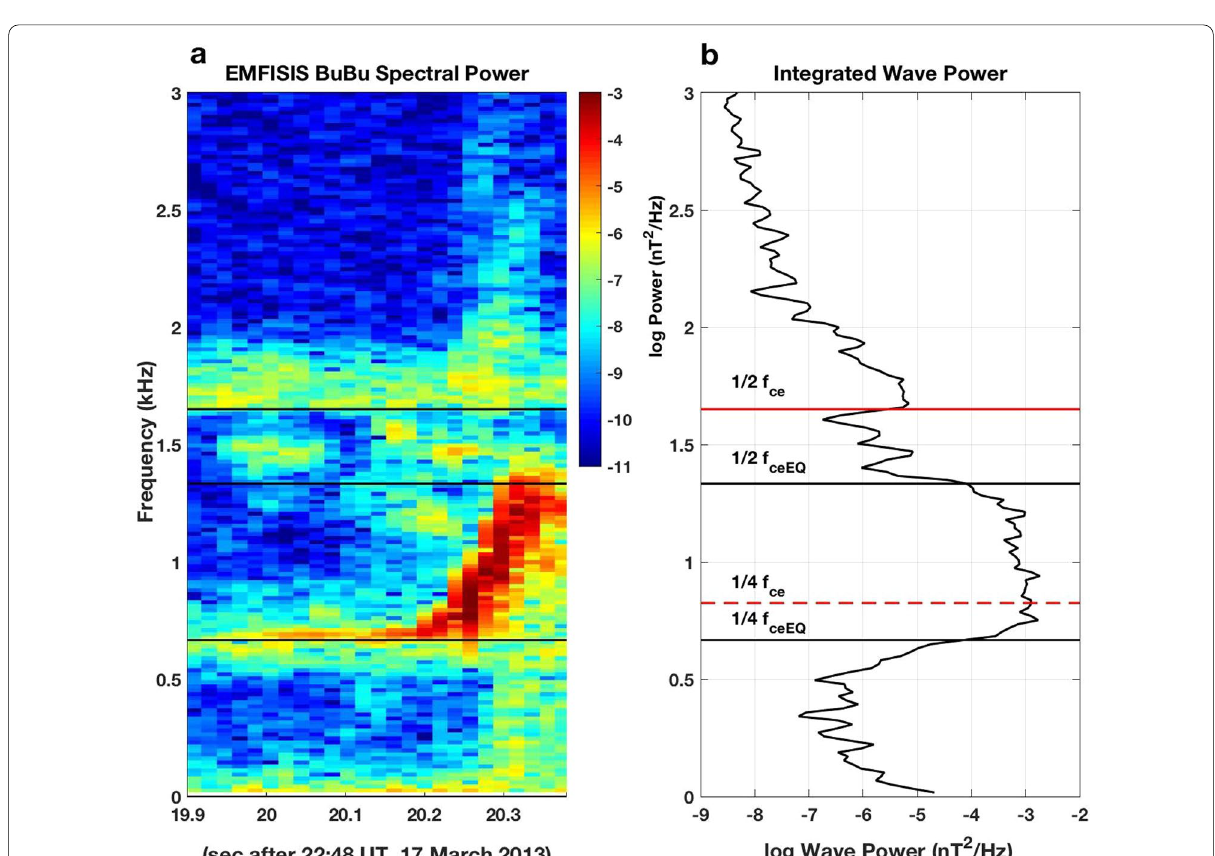
Fig. 3 a The magnetic field spectrogram observed near L 6.5 by Van Allen Probe B at 22:48:20 UT on 17 March 2013 exhibited clear damping = at frequencies below 1/2 the local electron cyclotron frequency. b Integrated signal power at each frequency is shown for the ~ 400 ms of observations shown in a . The local value of f ce is observed at the spacecraft and the equatorial value of f ce is determined from the characteristics of the damping of the chorus